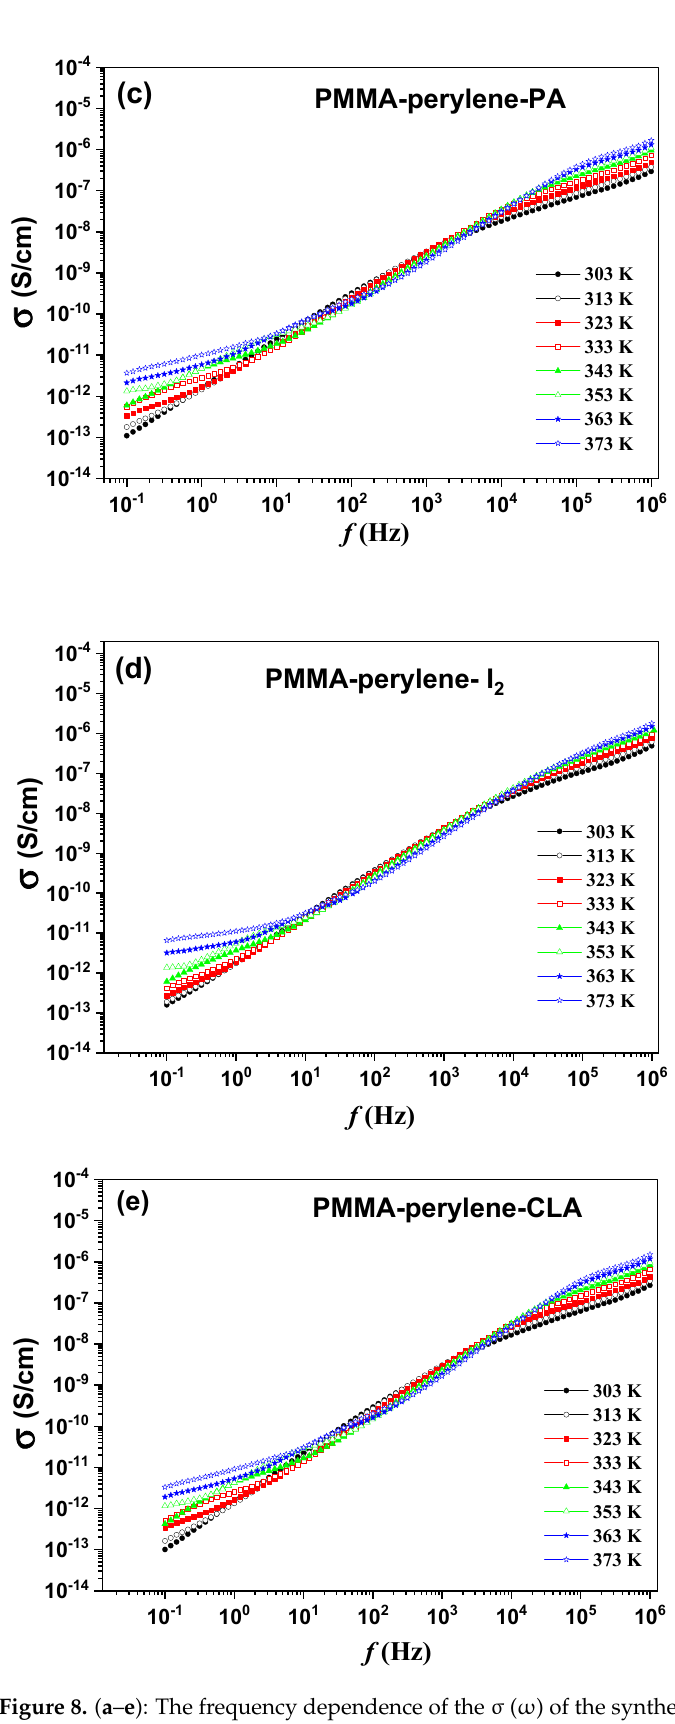
Figure 8. ( a – e ): The frequency dependence of the σ ( ω ) of the synthesized polymeric sheets.